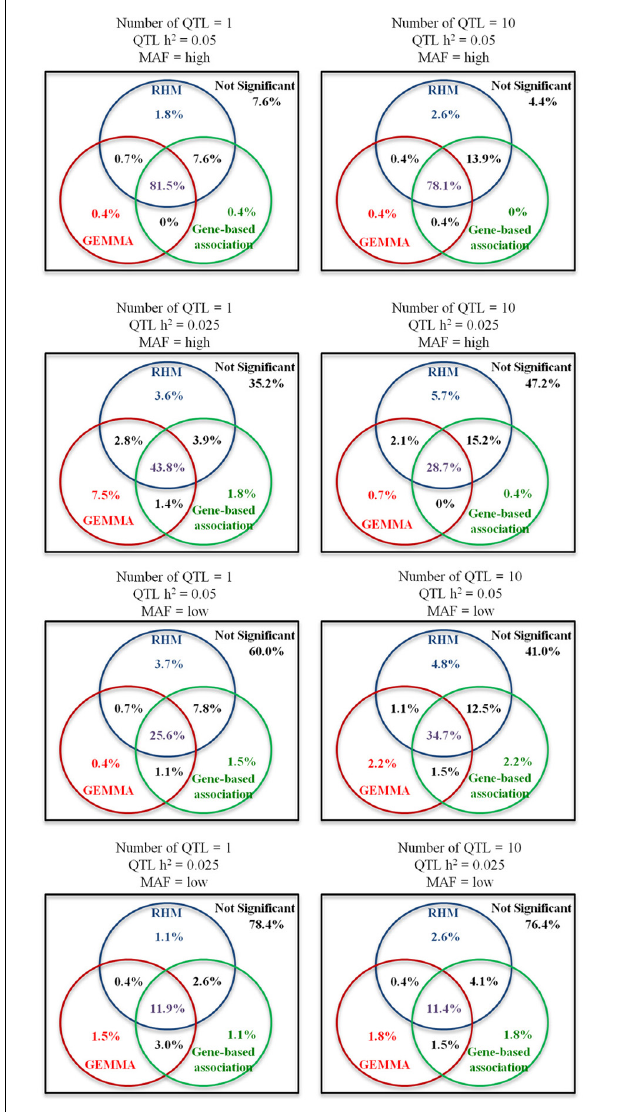
FIGURE 4 | Venn diagrams for comparisons of the significantly associated gene regions identified by three different methods. The percentages in circles are the proportions of the significantly associated gene regions identified by three different methods: blue circles for RHM, read circles for single-SNP GWAS (GEMMA), and green circles for gene-based association approaches including VEGAS, CCA, and SKAT (Gene-based association). Percentages in purple represent the significant replicates shared by all three methods, percentages in black represent the significant replicates shared only by two methods, and percentages in other colors are the significant replicates identified only by the corresponding method. The percentages in the squares are the proportion of not-significantly associated replicates. Each Venn diagram shows the different situations for genome heritability 0.4 (Number of QTL is 1 or 10, QTL heritability is 0.05 or 0.025, and MAF is high or low).